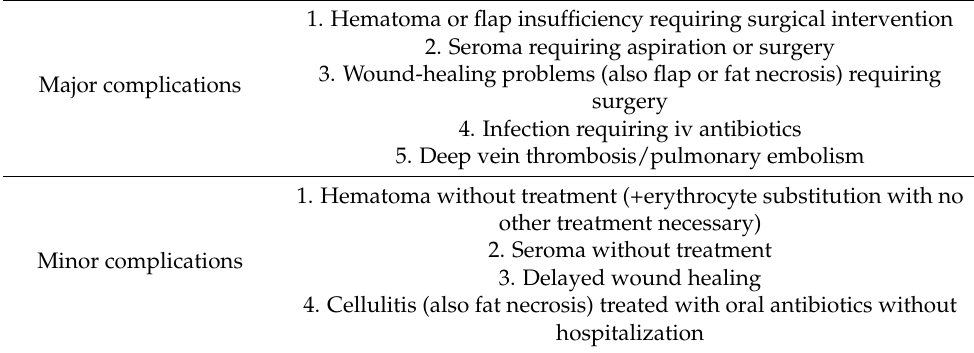
Figure 1. Schematic illustration of the study design. Table 1. Classification of complications modified from Neaman et al.